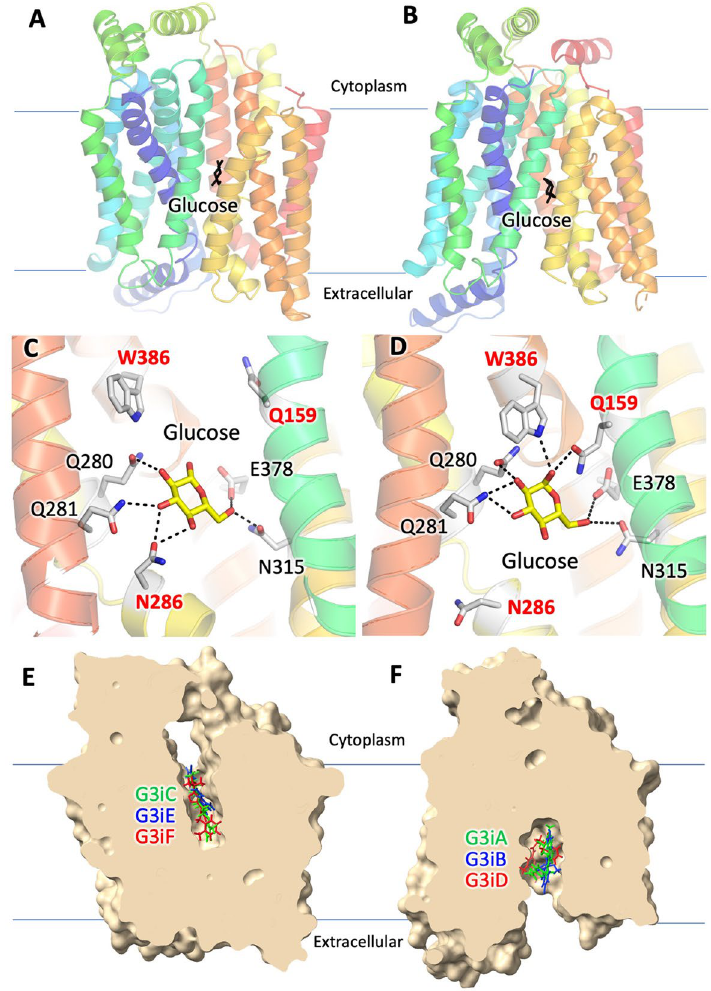
Figure 1. Models of the inward- and outward-facing conformations of GLUT3 showing the sites of selected docked ligands from the target-based virtual screening (TBVS). Overview of the GLUT3 models for the inward- facing (A) and outward-facing (B) conformations showing the glucose binding site (glucose as stick model, colored black). The rainbow coloring of the protein ribbon diagram starts with blue at the N-terminus and ends with red at the C-termius. Close-up of the glucose binding site in the inward-facing (C) and outward-facing (D) conformations of GLUT3. Glucose modeling was based on the glucosyl moiety of nonyl beta-D-glucopyranoside from PDB ID 4PYP (C) and alpha-D-glucopyranose-(1–4)-alpha-D-glucopyranose from PDB ID 4ZWC (D) . Glucose (yellow) and active site residues (grey) are shown as stick models. Dashed black lines represent hydrogen bond interactions. Side chains of Q159, N286 and W386 (red labels) adopt different conformations in the two conformations. Central slices through the GLUT3 isosurface showing the targeted ligand pockets in the inward-facing (E) and outward-facing (F) conformations. Validated ligand candidates from TBVS are shown as stick models, colored from the highest to the lowest potency as green, blue, and red (see also Table 1). (A,C,E) Homology model for the GLUT3 inward-facing conformation was generated in MOE, using as a template the crystal structure of GLUT1 (PDB ID 4PYP). (B,D,F) Structural model for the outward-facing conformation was the GLUT3 crystal structure PDB ID 5C65. The figures were generated with Pymol (https:// www. pymol. org) (A–E) and ChimeraX (https:// www. rbvi. ucsf. edu/ chime rax) (E–F)